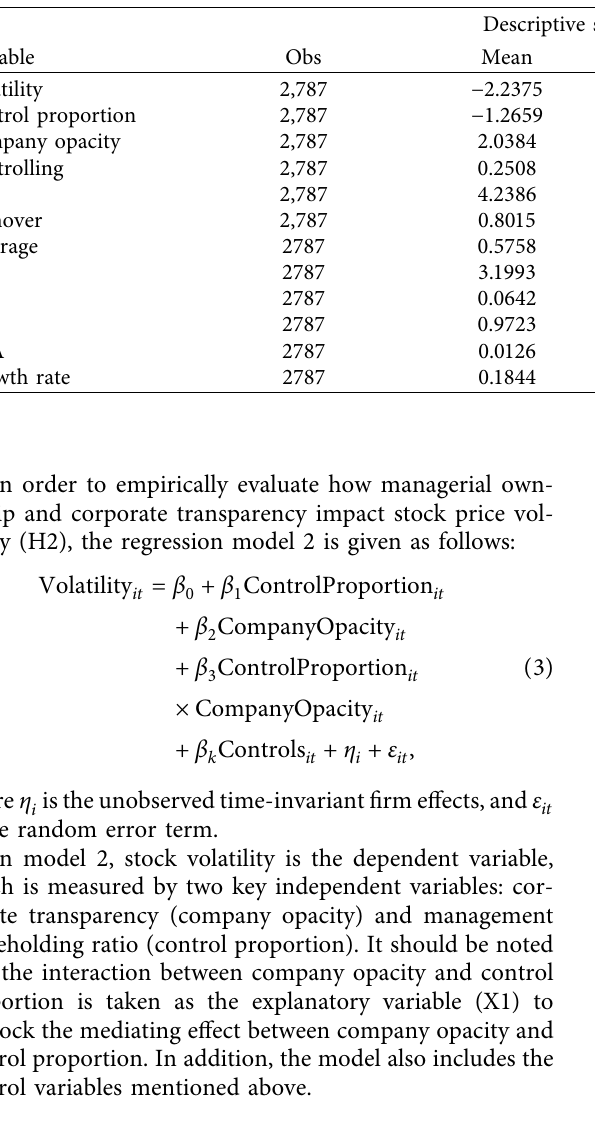
Table 3: Descriptive statistics of the key